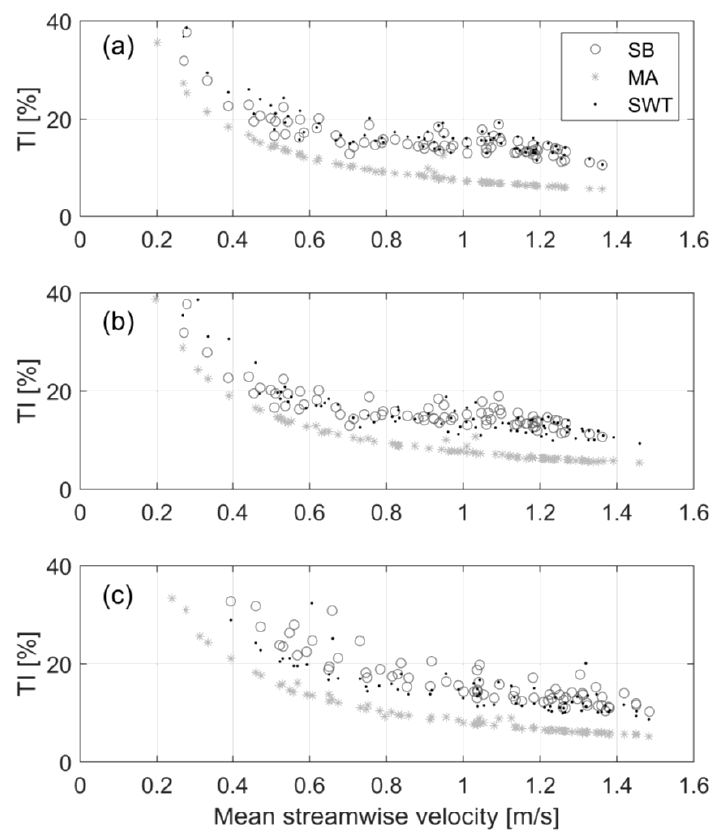
Figure 7. Streamwise turbulence intensities and mean velocity obtained with each method at ( a ) bottom tip height (10 m above seabed), ( b ) hub-height (15 m above seabed), and ( c ) top tip (20 m above seabed) from instrument CTb3.